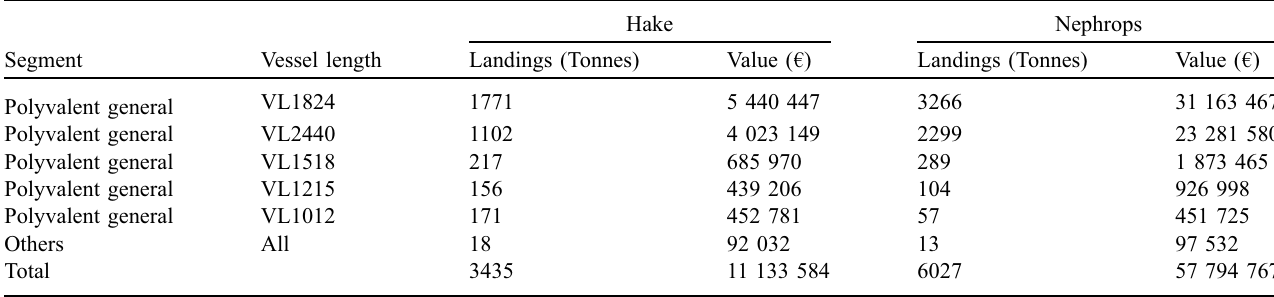
Table A.1. Landing statistics for hake and nephrops for the polyvalent general fl eet segment þ 18m in 2019.